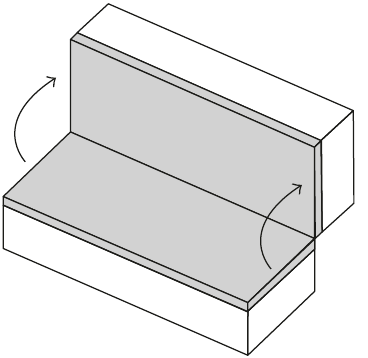
Figure 2: Failure A4: insufficient stress inside the joint.